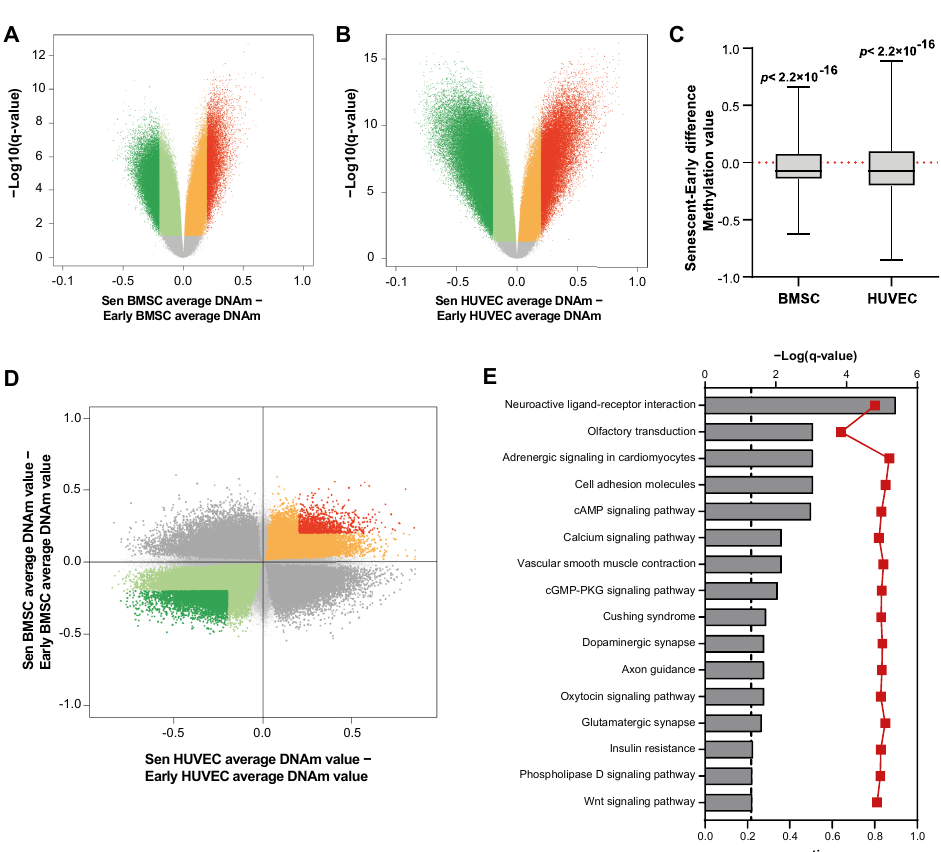
Figure 3. ( A , B ) Volcano plot showing differentially methylated CpGs (FDR < 0.05) in ( A ) Senescent (Sen) vs. early BMSCs and ( B ) Sen vs. early HUVECs. Differences in DNAm values are plotted against − log 10 (q-values). DMPs with an absolute DNAm difference >0.20 are highlighted in red (hypermethylated) and dark green (hypomethylated). ( C ) Boxplots showing the distribution of differences in the DNAm values of the CpGs between senescent and early BMSCs and HUVECs. p for Wilcoxon signed-rank tests. ( D ) Scatter plot comparing DNAm differences between Sen and early HUVECs and BMSCs. DMPs (FDR < 0.05) with concordant senescence-associated hypo- and hyper- methylation are indicated in green and red, respectively; DMPs with an absolute DNAm difference >0.20 are highlighted with darker green and red colors. ( E ) KEGG pathways significantly enriched in genes containing DMPs that are common to both cellular lineages in senescence. Pathways are ranked according to the significance of enrichment (grey bars, upper y -axis). Ratios referring to the proportion of targeted genes related to the total number of genes in each pathway are displayed (red line graph, bottom y -axis).